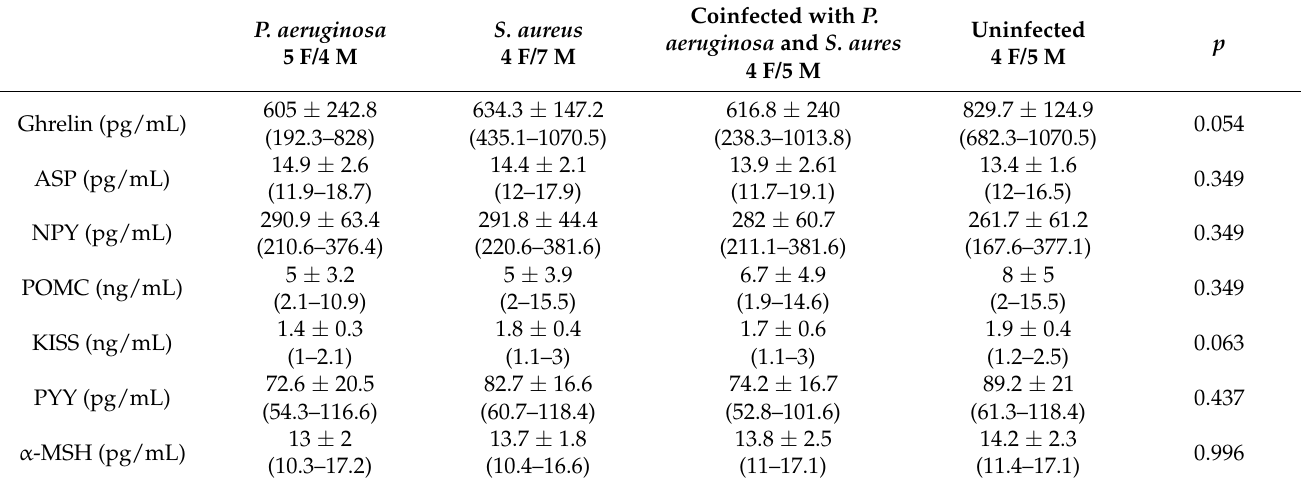
Table 3. Levels of hormones depending to the type of bacterial infection